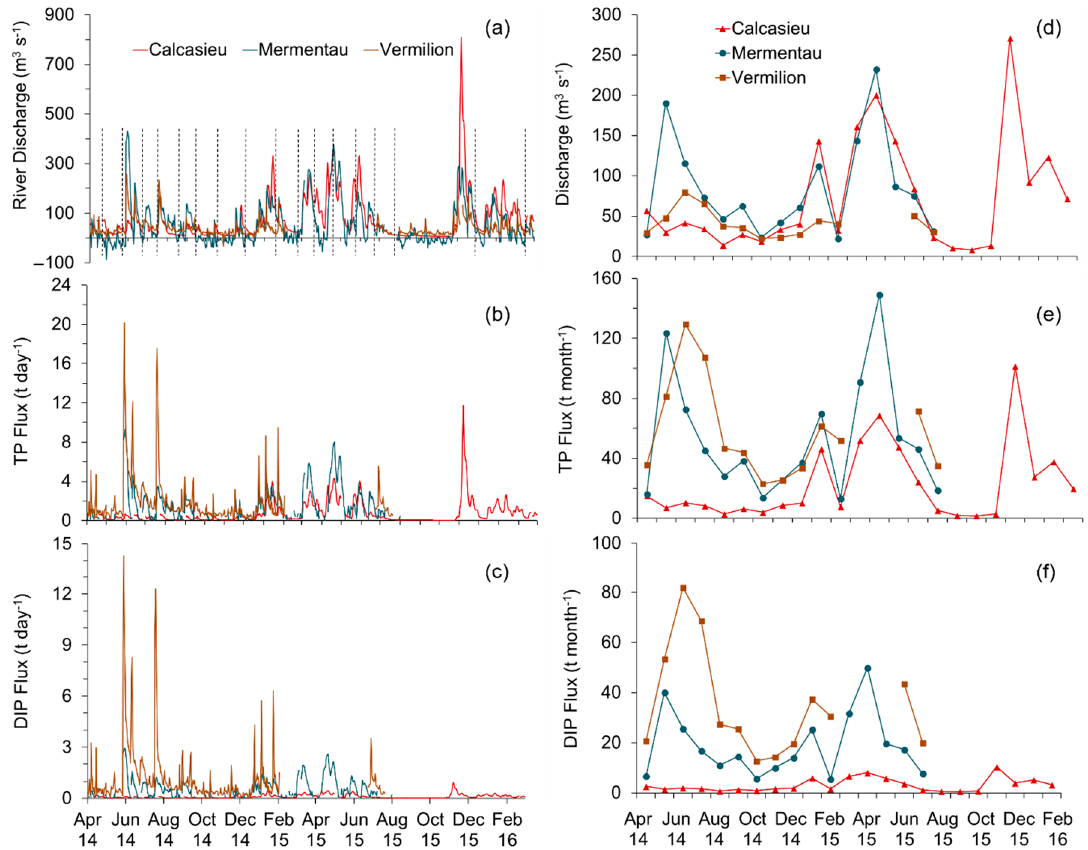
Figure 2. Daily ( a – c ) and monthly ( d – f ) discharge and mass fluxes of TP and DIP in the Calcasieu (Site 1), Mermentau, and Vermilion Rivers from April 2014 to February 2016; discharge data at sites 1, 7, and 8 were used to represent the three rivers; Discharge at site 1 was calculated using discharge data at Kinder (USGS 08015500). Discharges at sites 7 and 8 were downloaded from USGS gage stations (USGS 08012150 and USGS 07386980); dashed lines in ( a ) mark the sampling dates; phosphorus concentrations and discharges at sites 1, 7, and 8 were used to calculate mass fluxes for the Calcasieu, Mermentau, and Vermilion Rivers, respectively; missing data for the Mermentau and Vermilion Rivers are due to availability of phosphorus concentration and discharge data. Table 3. Pearson Correlation Coefficients between phosphorus and environmental factors in the